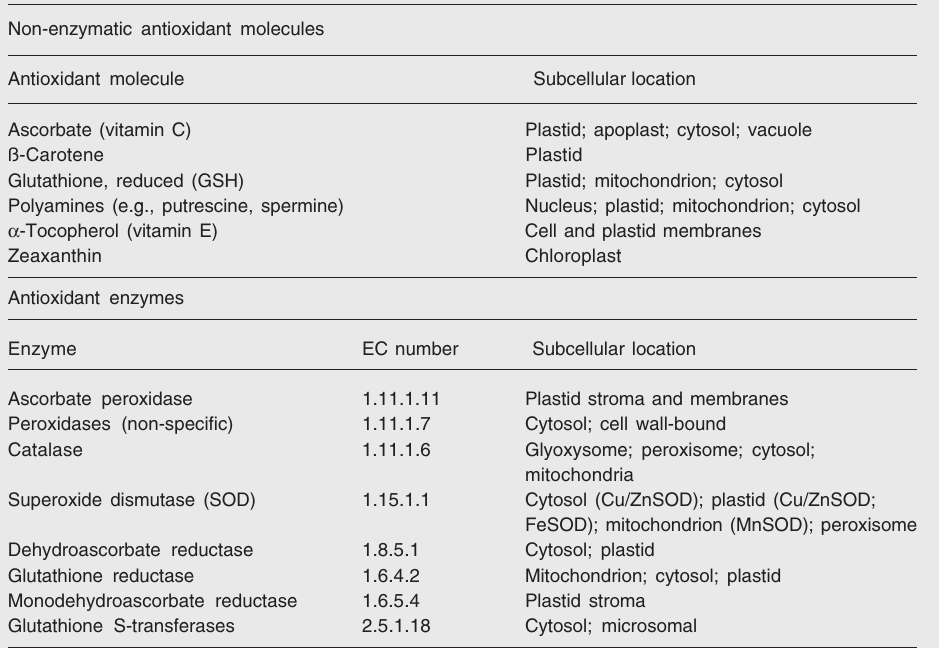
Table 3. Some natural